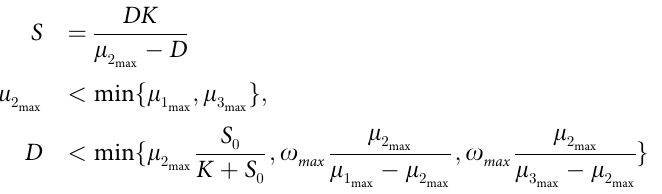
S1 Fig. Posterior distribution of chaotic objective for gLV model. Posterior distribution of of all